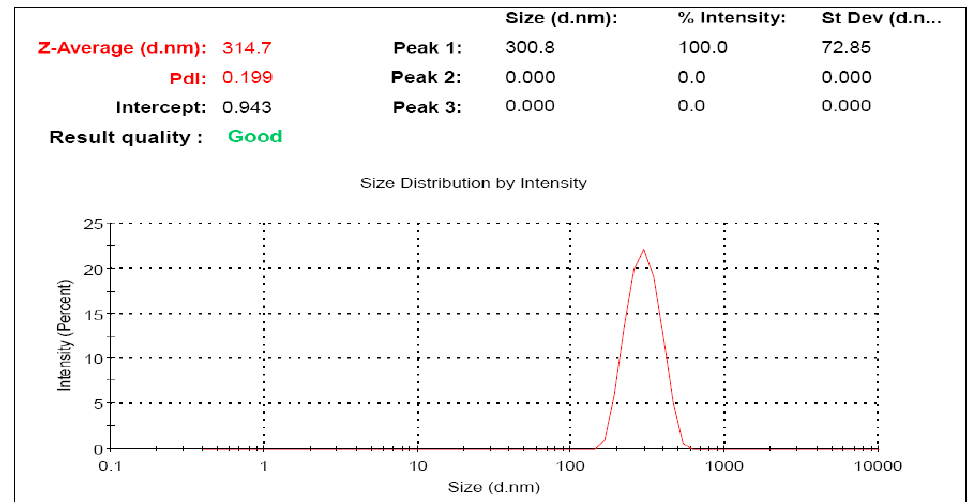
Figure 4. Vesicular size distribution curve of optimized Silymarin loaded transfersomal formulation.